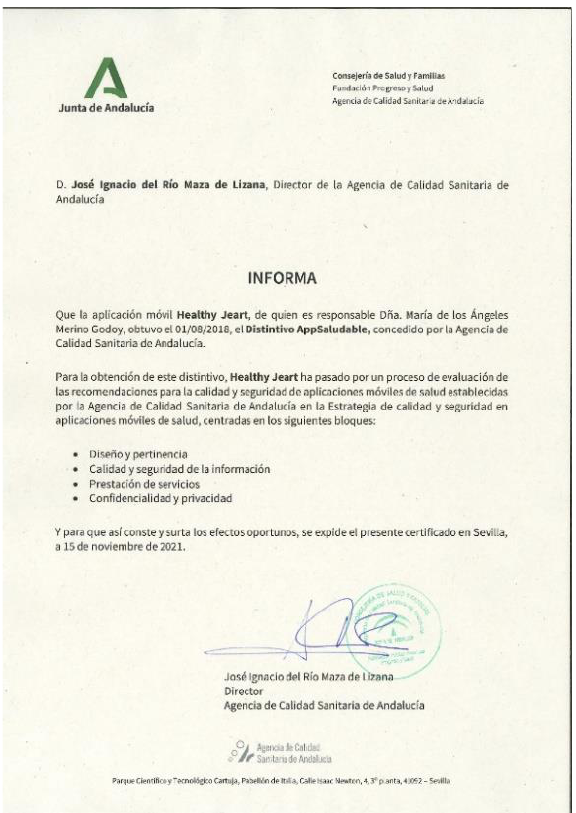
Figure A1. Distinction of “Healthy App”.